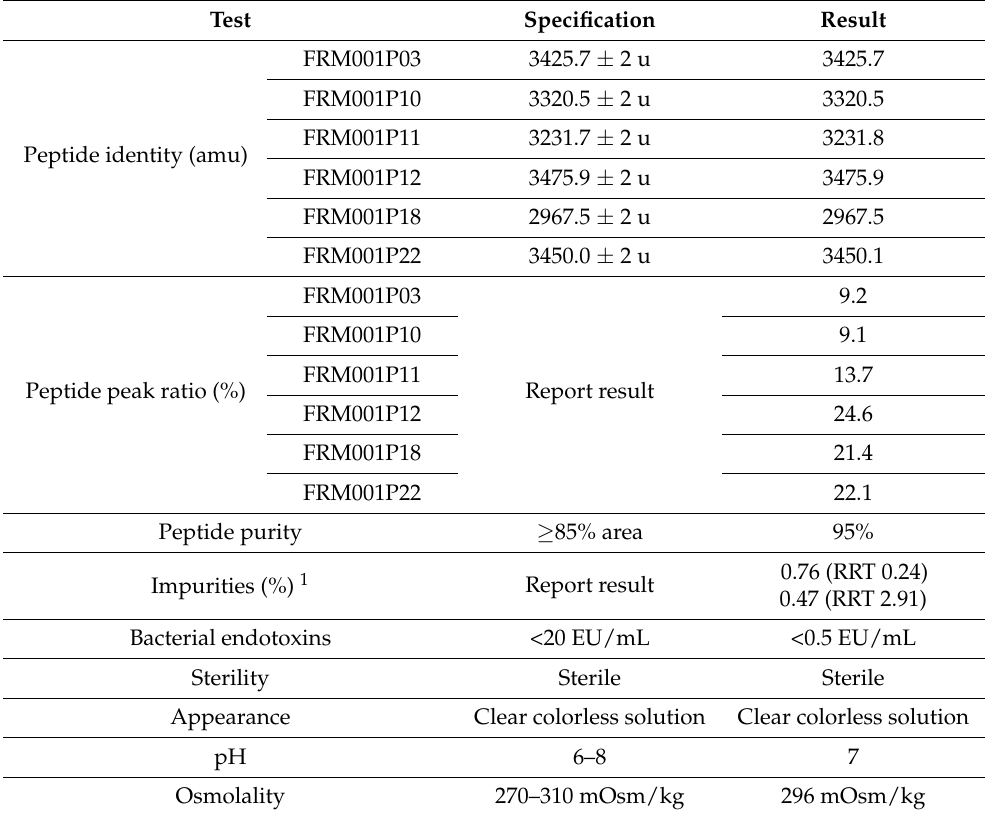
Table 5. The tests results of peptide mixture FRM001-M2 that was manufactured under GMP